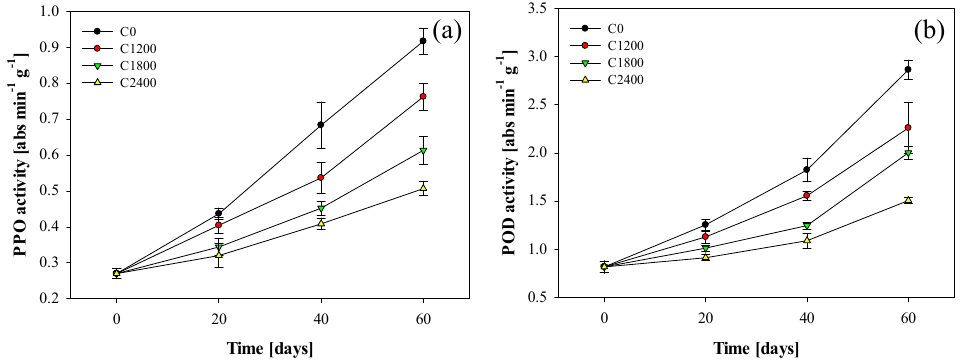
Figure 4. Values of ( a ) PPO activity, and ( b ) POD activity of untreated (control) and coated (CEO concentration = 1200–2400 μ L/L) apple fruits during 60 days of cold storage (4 °C).